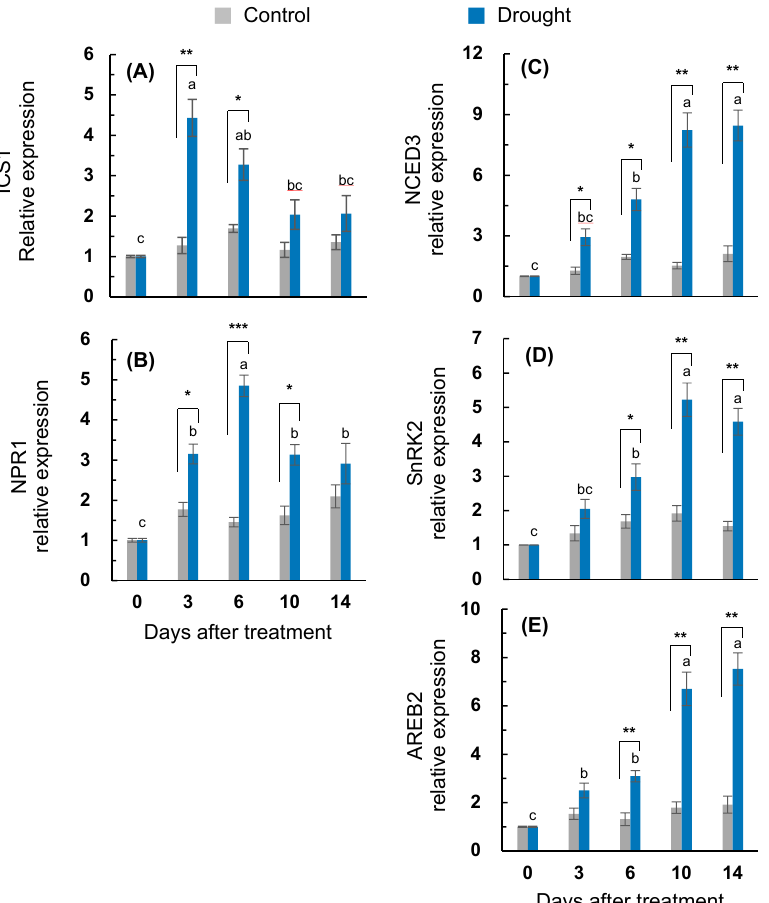
Figure 2. Changes in the expression of the ( A ) salicylic acid (SA) synthesis-related gene isochorismate synthase 1 ( ICS1 ), ( B ) SA-signaling gene, non-expressor of pathogenesis-related gene ( NPR1) , ( C ) ABA synthesis-related gene 9-sis-epoxycarotenoid dioxygenase ( NCED3 ), ( D ) sucrose non-fermenting − 1 (Snf1)-related protein kinase 2 ( SnRK2 ), and ( E ) ABA-responsive element binding 2 ( AREB2 ) in the leaves of the well-watered control or drought-stressed plants during 14 days of treatment. Data are presented as the mean ± SE from duplicates for each of the four independent plants. Bars labeled with different letters in the drought-stressed plants are significantly different at p < 0.05, according to Duncan’s multiple range test. Asterisks denote a statistical difference between the drought treatment and control: * p < 0.05, ** p < 0.01, and *** p < 0.001.